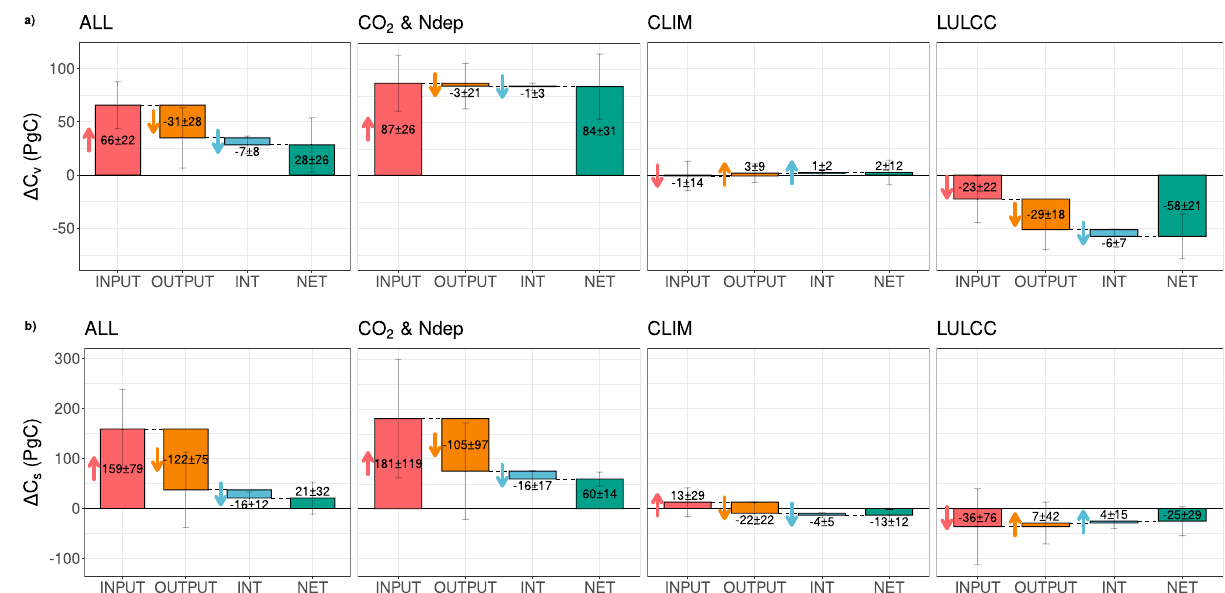
Fig. 4 | Process and driver attribution of changes in global vegetation and soil carbonstocks. Changeinglobal a vegetation( Δ C v ) and b soil ( Δ C s ) carbonstocks over 1959 – 2020 (PgC). The contribution to net changes in carbon stocks (green bars) fromchanges in inputs (net primary productivityfor vegetation ( Δ NPP τ v ,1959 ) and vegetation to soil fl ux for soil ( Δ f vs τ s ,1959 ), red bars), outputs/turnover (NPP 1959 Δτ v forvegetationand f vs ,1959 Δτ s forsoil,orangebars),andtheinteraction